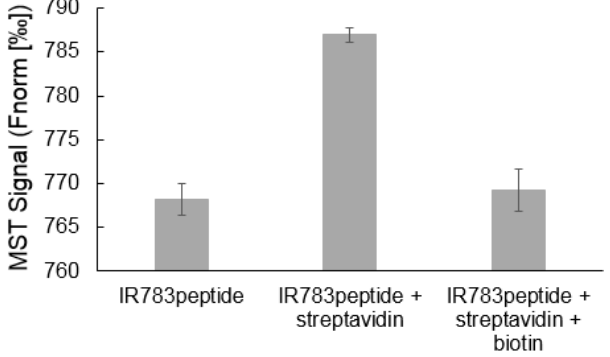
Figure 6. Microscale thermophoresis showing distinct signals for the IR783-VSHPQAPF probe before and after binding to streptavidin revealing a clear binding event and again returning to its original signal upon addition of native biotin confirming the release of the probe from streptavidin.